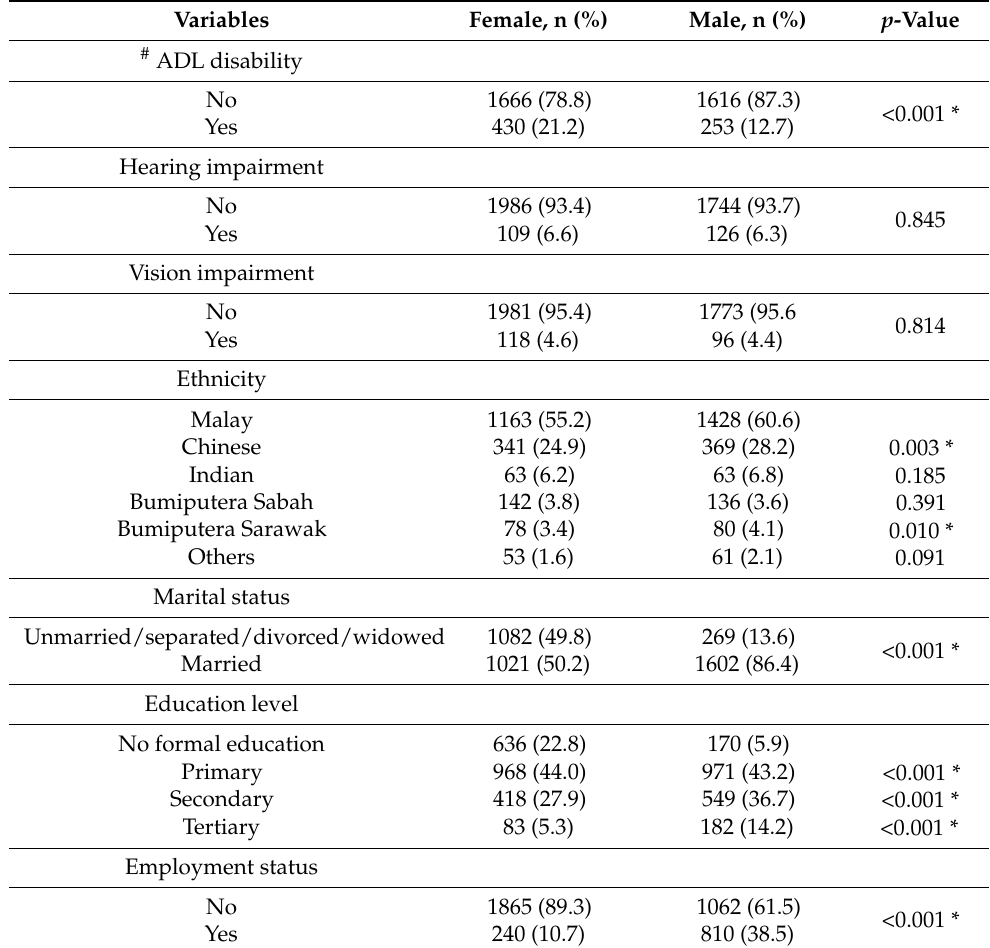
Table 1. Characteristics of study respondents according to